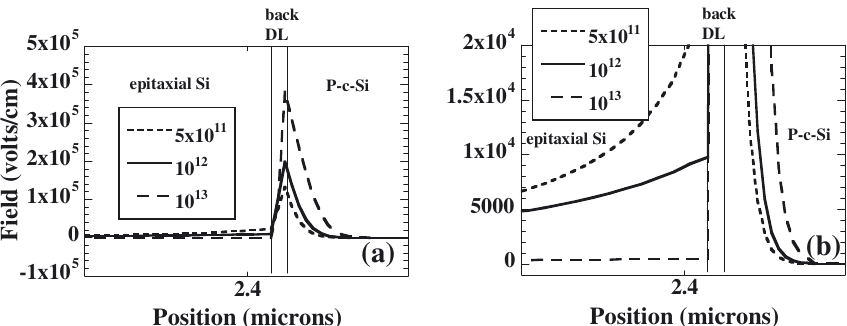
Fig. 7. The electric field (a) inside and near the rear defective layer (DL) on the epi-Si surface and (b) this field shown in an expanded scale inside the epi-Si layer close to this DL, for the 2.4 μ m epi-Si layer cell under AM1.5 light and open-circuit conditions with the defect density at the epi-Si/P-c-Si interface as a parameter.